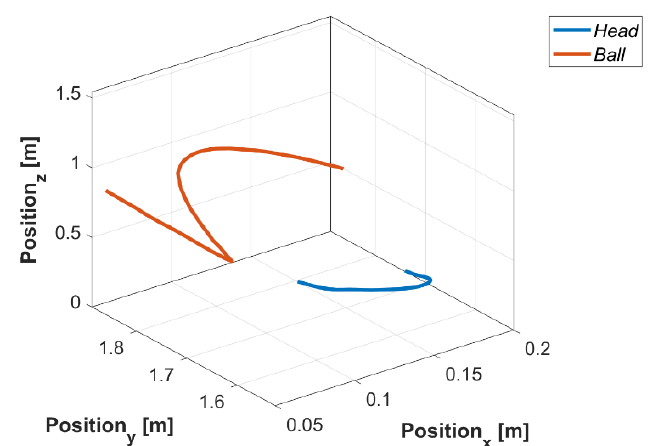
Figure 5. Three-dimensional (3D) position trajectories of the ball (red line) and head (blue line) during a heading impact recorded by the optical motion capture system.